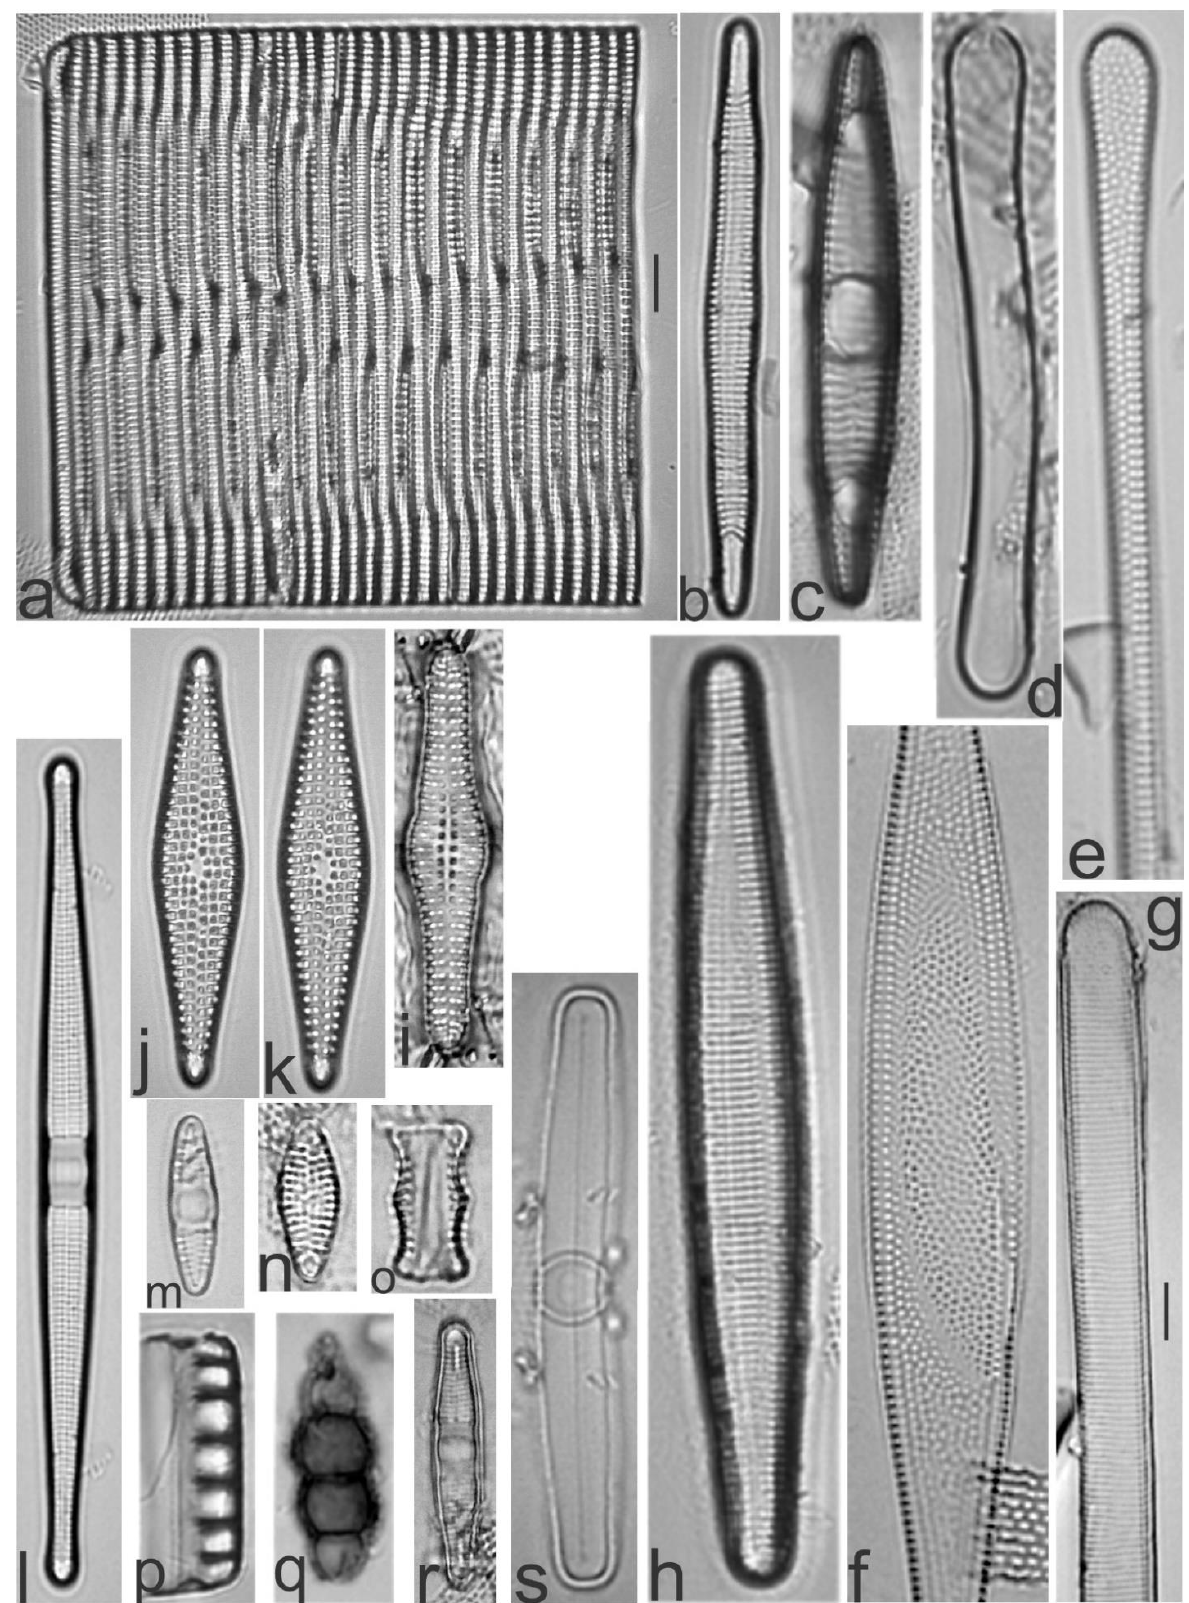
Figure 7. ( a – c ) Rhabdonema adriaticum ; ( d ) Diatom sp.; ( e , f ) Toxarium hennedyanum ; ( g ) Ardissonea fulgens ; ( h ) Synedra bacillaris ; ( i ) Rhaphoneis elegantula ; ( j , k ) Glyphodesmis sp.; ( l ) Plagiogramma interruptum ; ( m ) Plagiogramma cf. gregorianum ; ( n , o ) Dimeregramma minor var. nana ; ( p ) Eunotogramma laevis ; ( q ) E. variabile ; ( r ) Talaroneis sp.; ( s ) Cyclophora tenuis . Scale bars = 5 μm.